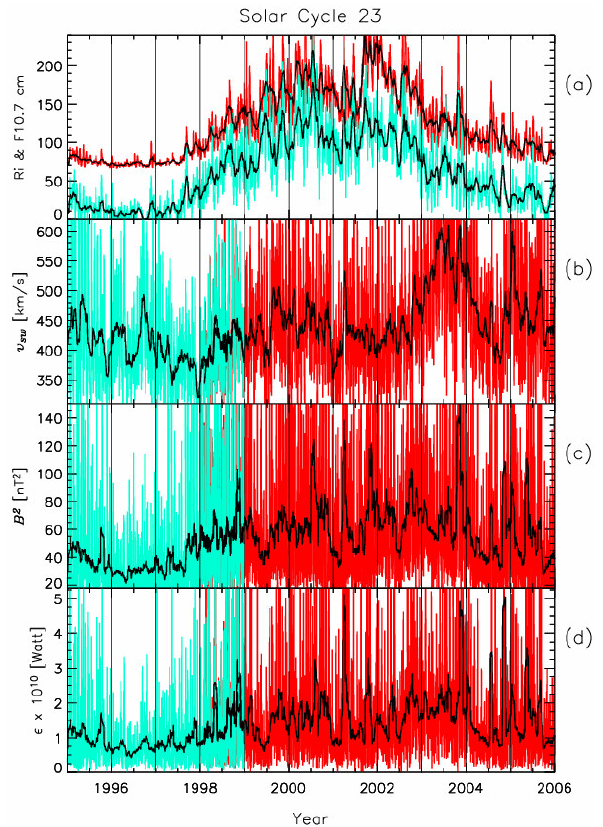
30 Fig. 2. (a) Daily 10.7cm solar flux measurements (red) and sunspot